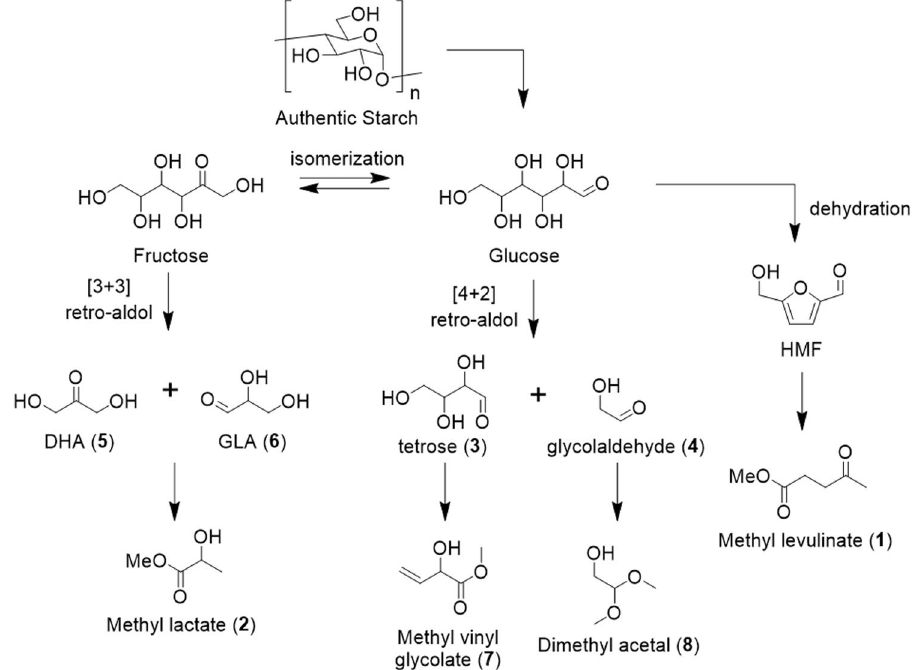
Figure 5. Transformation of starch into 1 , 2 , and several other important chemicals.